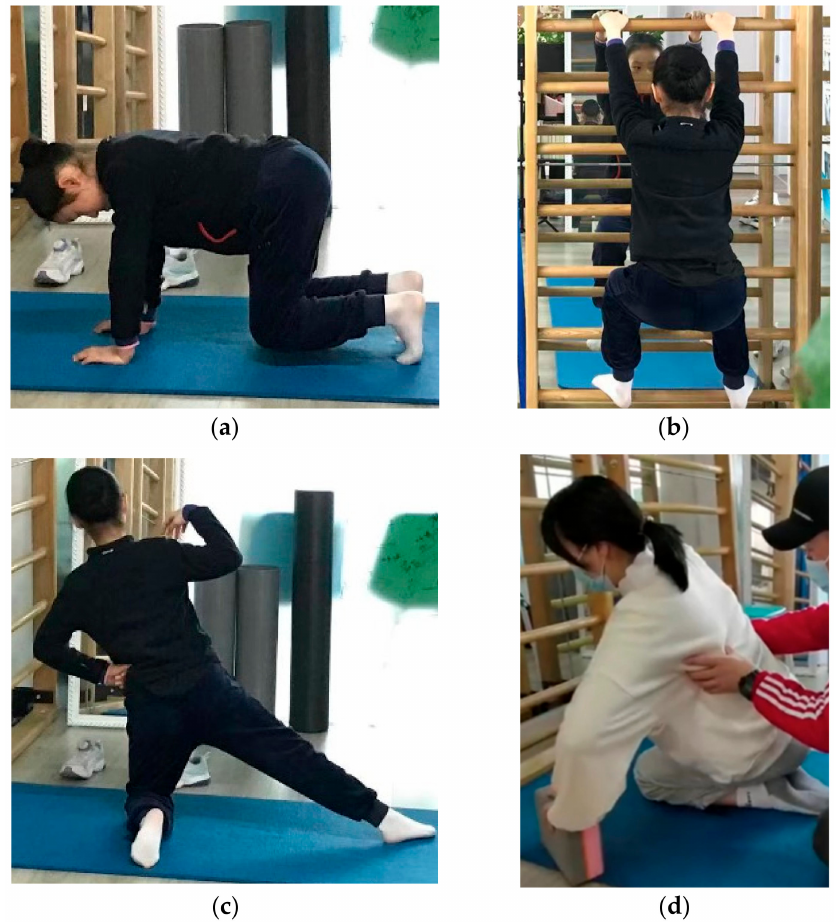
Figure 1. Four different Schroth exercise positions: ( a ) E1—on the fours, ( b ) E2—squatting on the bar, ( c ) E3—kneeling on one side, ( d ) E4—sitting with side